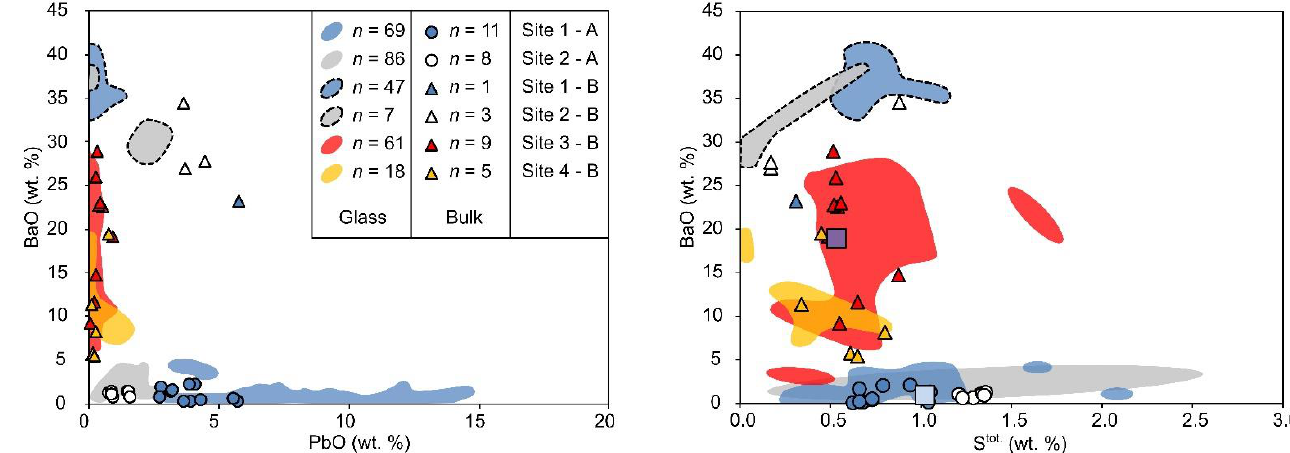
Figure 9. Selected bivariate plots of bulk and glass composition.